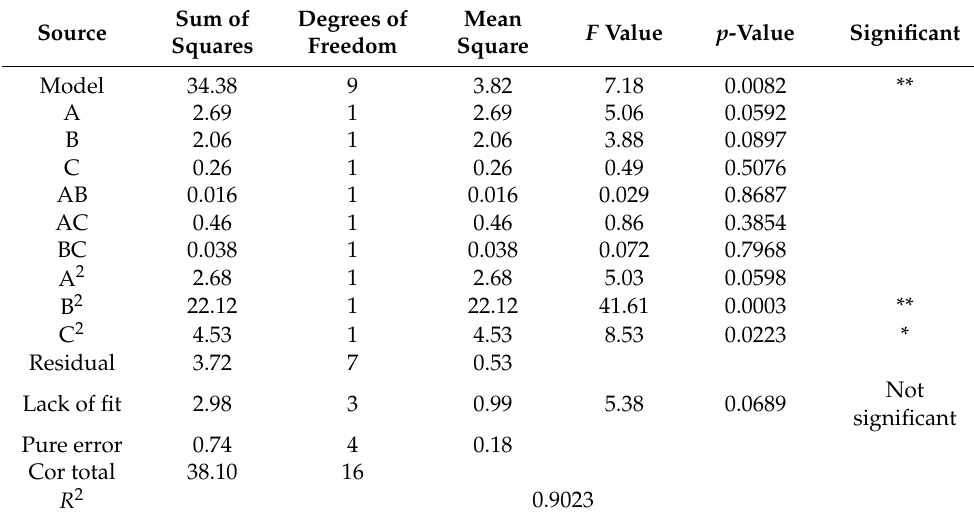
Table 10. Variance analysis of the response surface methodology for the second stage of the